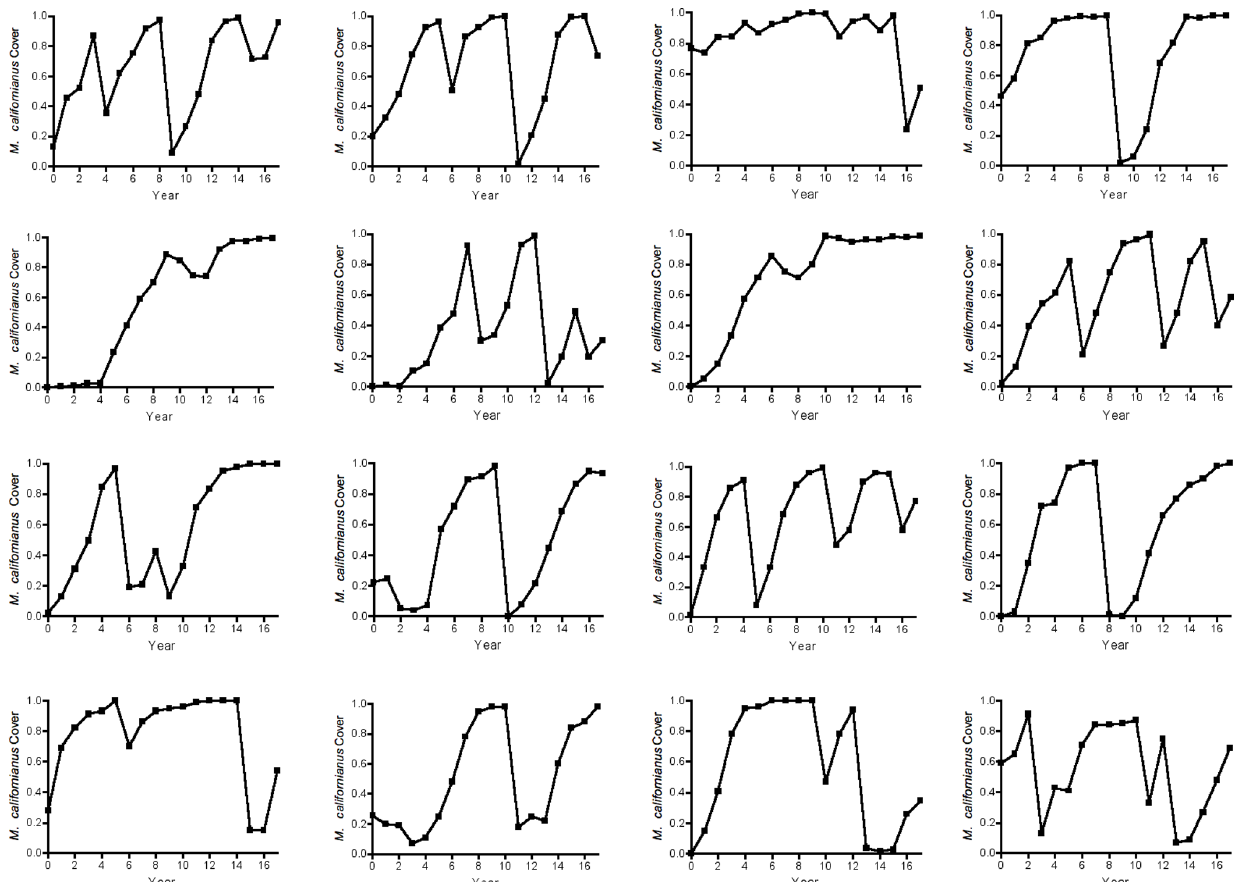
Figure 7. Graphs of 16 simulations of Mytiluscalifornianus population dynamics. Simulations used the best-fitting density-linked stochastic model (Equations 3, Table 2).